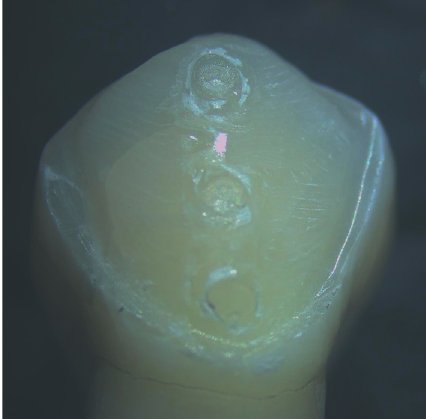
Figure 4: Stereomicroscopic evaluation of failure modes at 18x magnification. Types of failure modes: cohesive (occlusal third), mixed (middle third), and adhesive (cervical third).